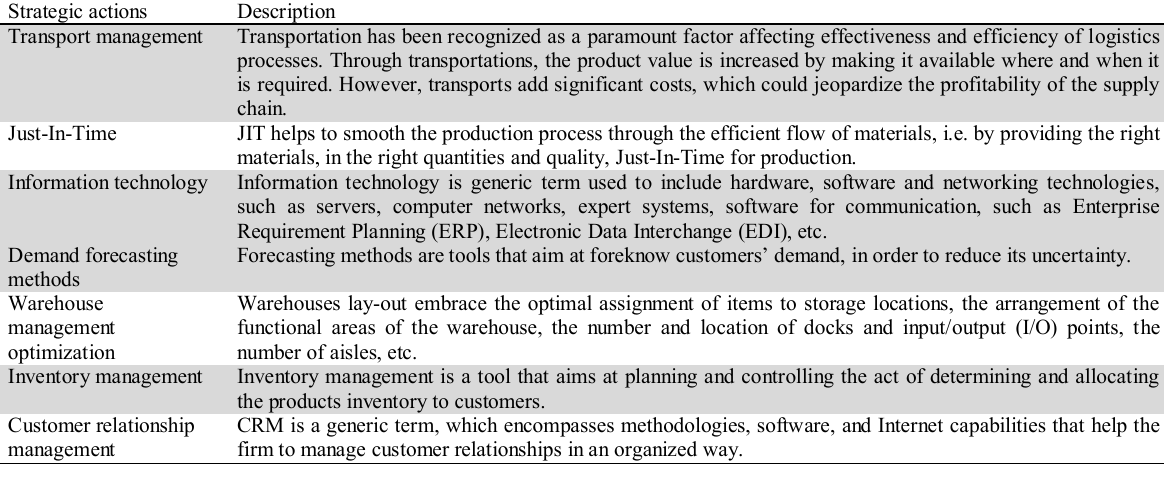
Strategic actions considered in HEPCO